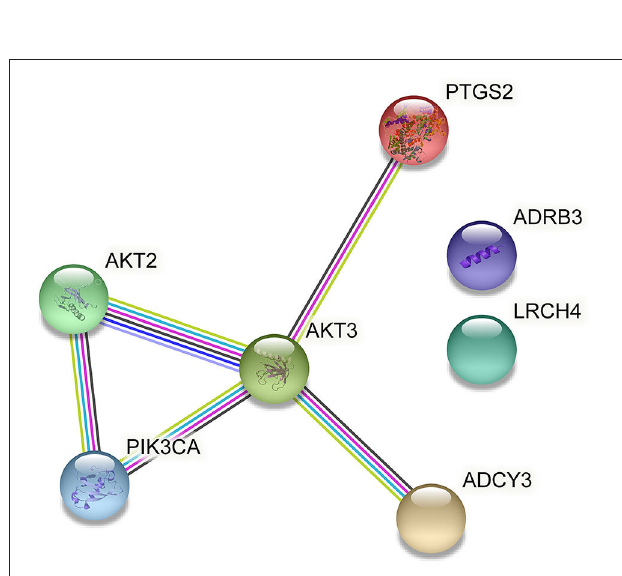
FIGURE 6 | KEGG pathway analysis of the target genes. The X-axis is the rich factor, and the Y-axis is KEGG pathway.